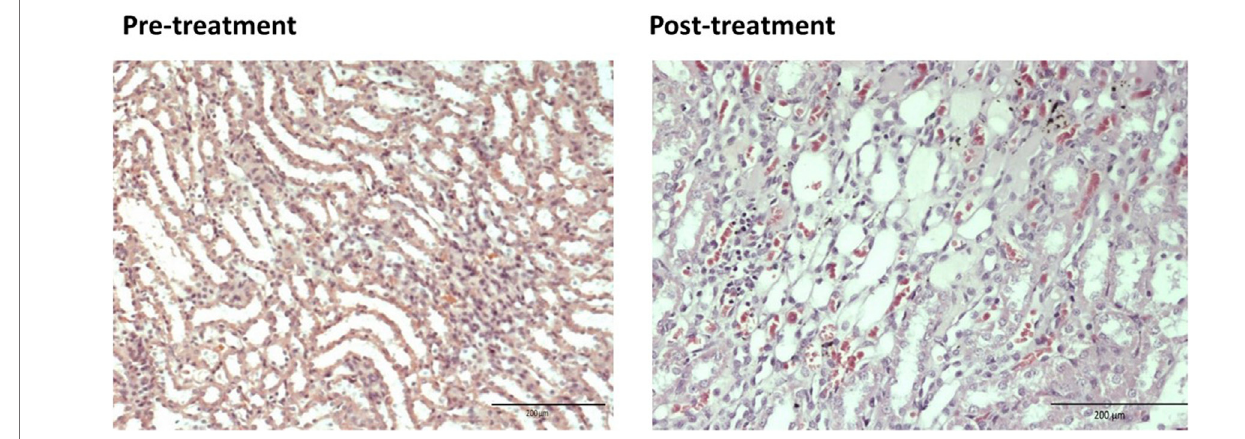
FIGURE 2 | Negative contol (GTN and saline) Severe ATN changes in the tubles.